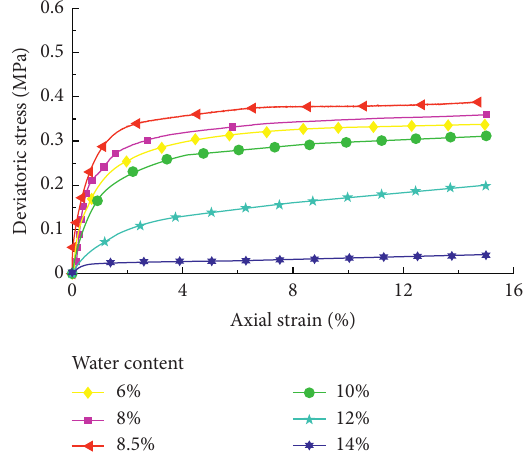
Figure 6: Deviatoric stress-axial strain behavior for natural soil with different water contents (confining pressure � 0.1MPa; compaction degree � 100).